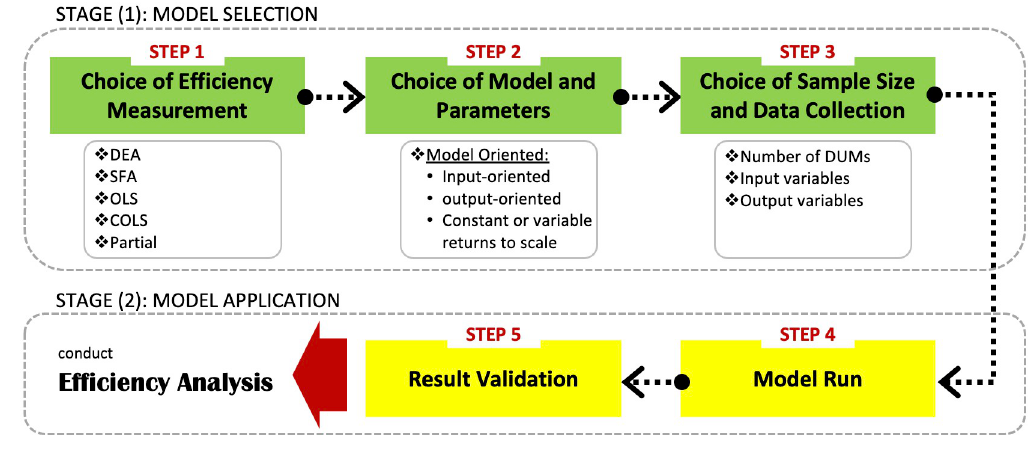
Fig 3. Efficiency assessment analysis